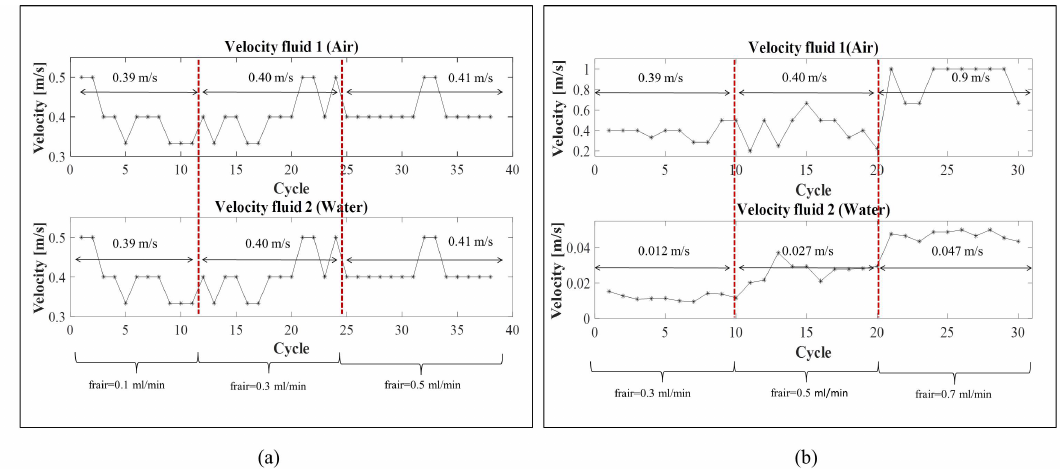
Figure 10. Velocity trends of the water and air fluids computed in real-time ( a ) in the serpentine microchannel G-320 and ( b ) in the serpentine microchannel